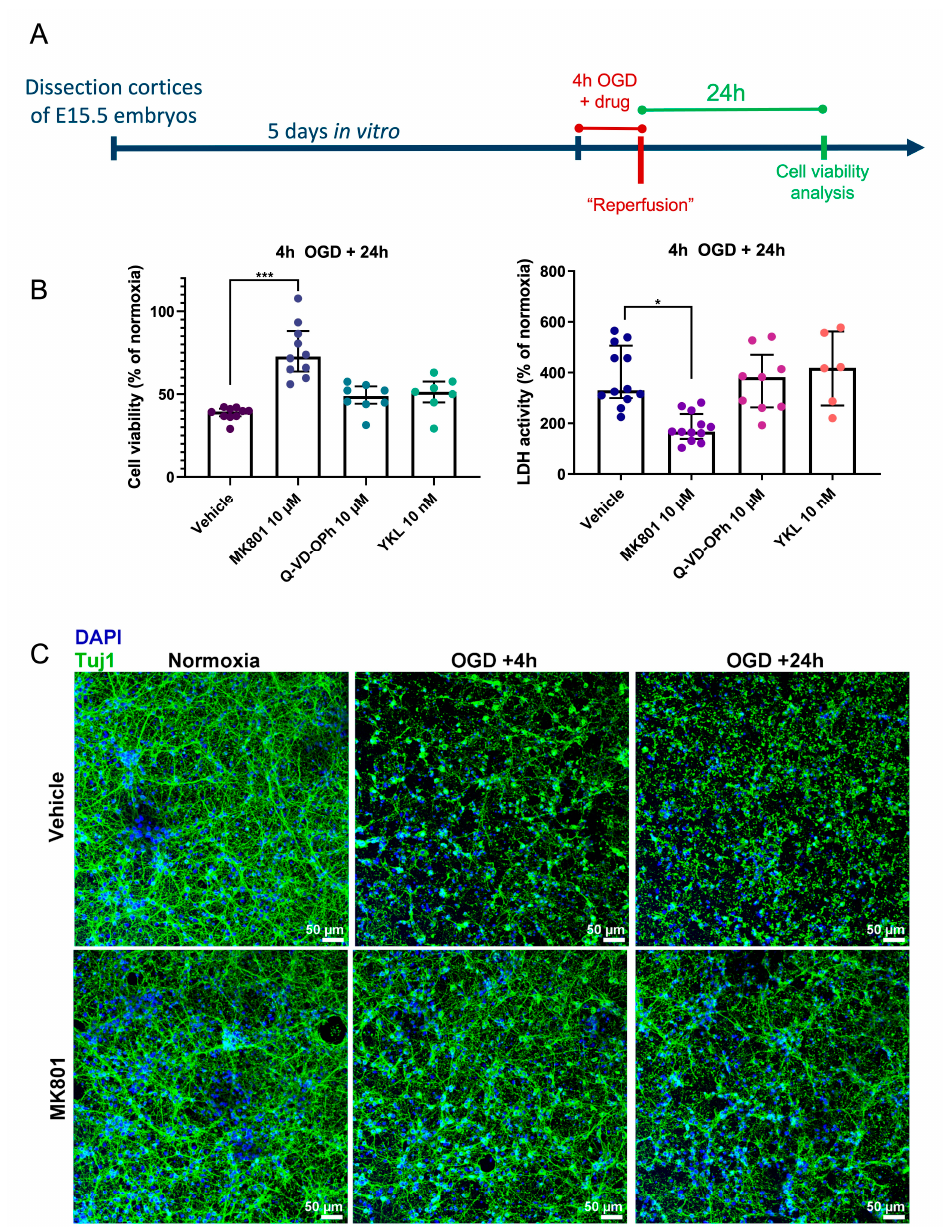
Figure 1. Inhibition of the NMDA receptor protects against ischemic neuronal death, but not in- hibition of Cdk7 or caspases. ( A ) Experimental timeline. Primary cortical neurons were obtained from E15.5 mouse embryos. At DIV5, neurons were exposed to 4 h of OGD, while incubated with vehicle (0.1% DMSO) or a specific inhibitor of either Cdk7, the NMDA glutamate receptor, or caspases. Viability and cytotoxicity were assessed 24 h after the end of OGD. ( B ) Viability of primary cortical neurons exposed to 4 h of OGD in the presence of either vehicle only (0.1% DMSO), the NMDA receptor antagonist MK801, the pan-caspase inhibitor Q-VD-OPh, or the Cdk7 inhibitor YKL-5-124 (“YKL”). Neurons were incubated with 0.1% DMSO in all conditions. Viability was measured with the CCK8 assay (left), while cytotoxicity was quantified using the LDH assay (right). Values are